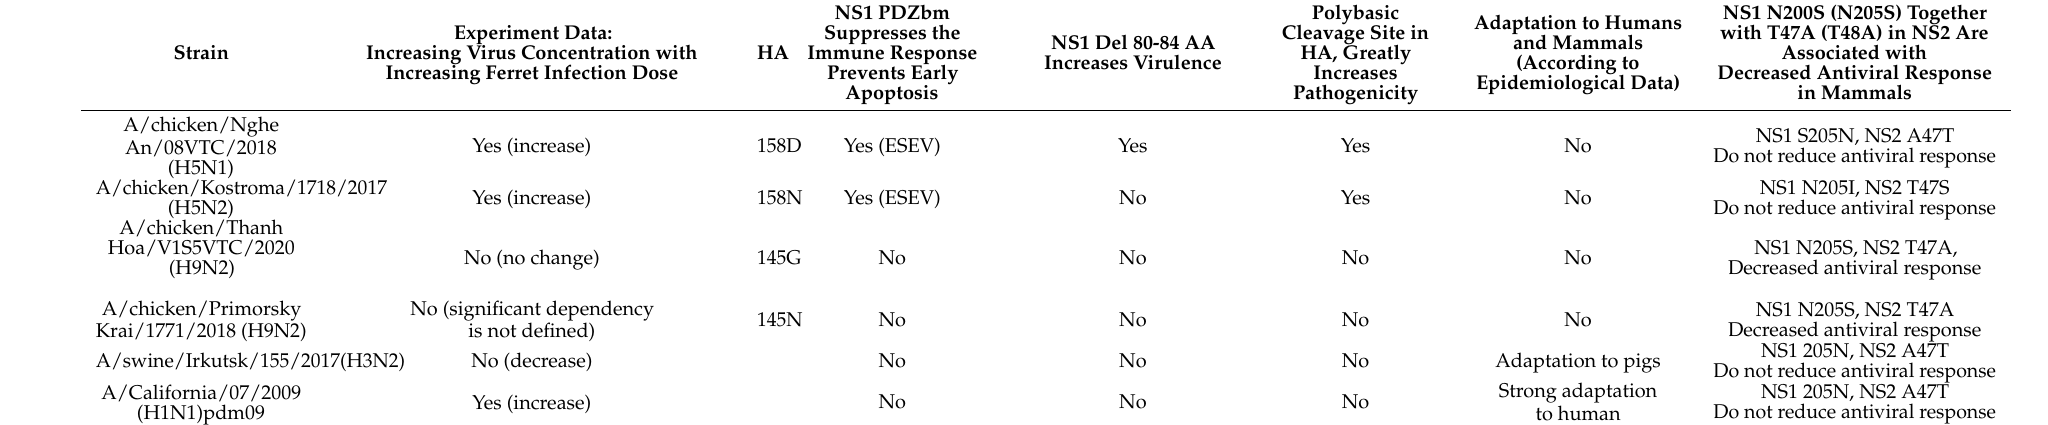
Table 1. Molecular markers of virulence and transmissibility in the HA and NS genes of the studied H5N1, H5N2, and H9N2 viruses.